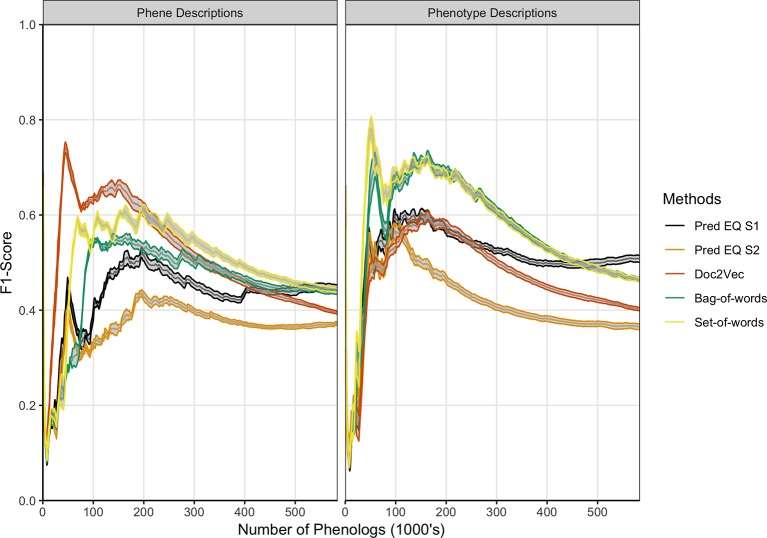
Comparison of phenolog pairs identified by predictive methods in comparison to the Oellrich, Walls et al. (2015) dataset. The x-axis indicates the number of phenologs pairs (highest valued edges in the phenotype similarity network) at each point. The standard deviation of resampling with 80% of the phenotypes in the dataset (network nodes) are indicated by ribbons for each method. Phene descriptions (left) or phenotype descriptions (right) were used as the text input for each particular method.